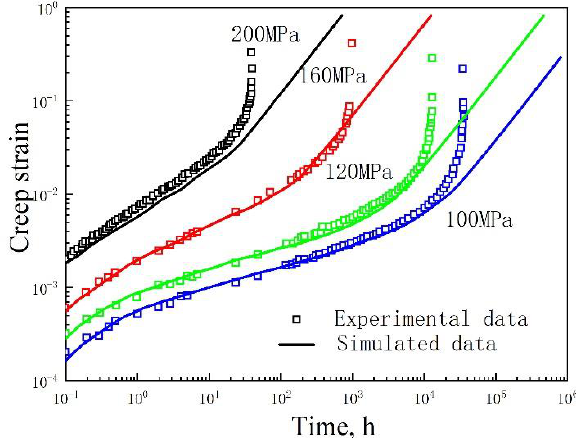
Figure 6. Uniaxial tension test under different stress levels [22].